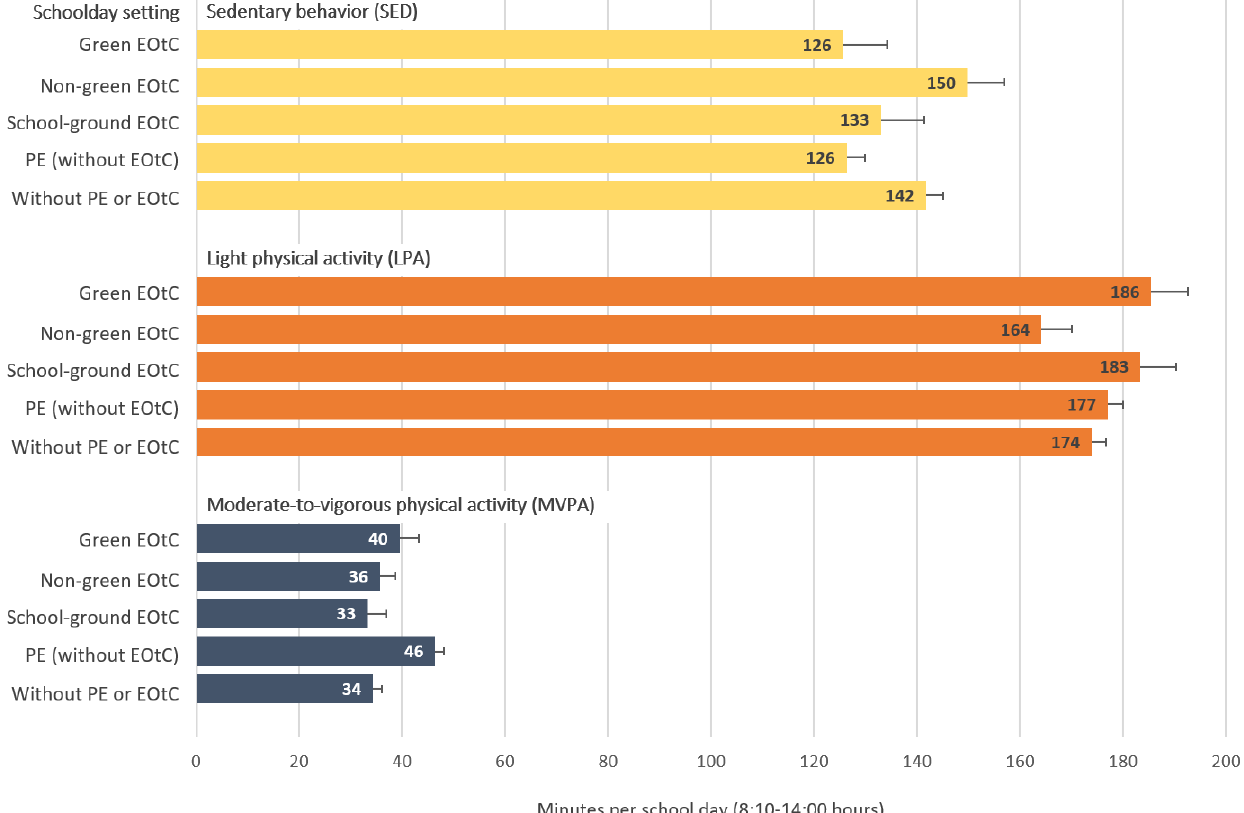
Figure 1. Minutes spent in SED, LPA and MVPA during the school day in different school day setting categories. Estimated marginal means of the linear-mixed models with SED, LPA and MVPA as fixed effects separately with cases nested in pupils, in classes, and in schools as random effects. Models are adjusted for duration of EOtC sessions, duration of active and passive transportation and duration of break/free time during EOtC sessions; sex; age; and BMI. Error bares represent the ±SD of its sampling distribution.